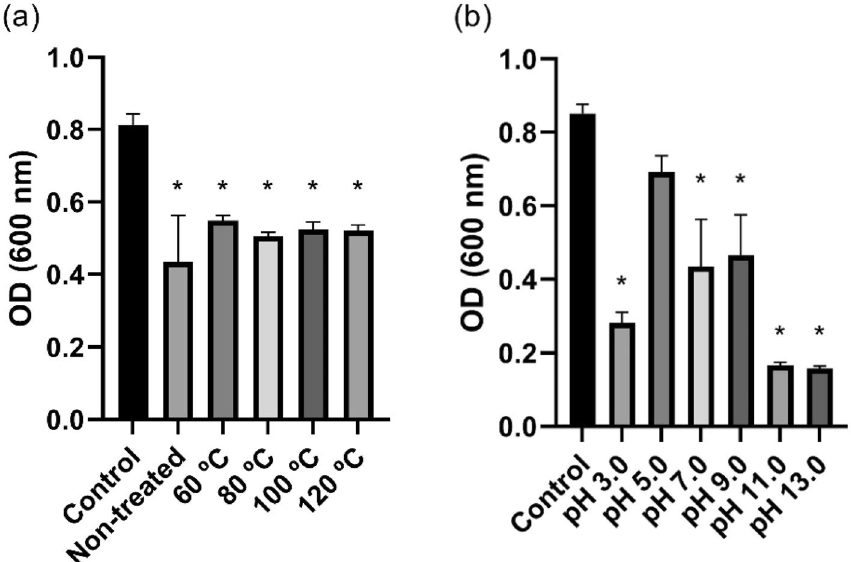
Figure 1. Optical density (OD) of Gardnerella vaginalis suspension incubated for 24 h with 5% (v/v) Lactobacillus paracasei CH88 cell-free supernatant treated at different temperatures for 30 min ( a ) and different pH ( b ). Bars are means and standard errors of the means (n = 3) of triplicate experiments. *Significant difference compared to the control ( p < 0.05; one-way ANOVA with Dunnett’s multiple comparison